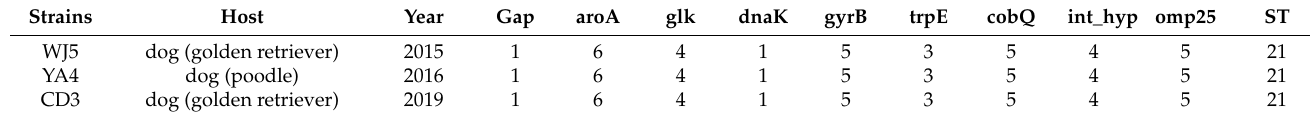
Table 4. Allelic profiles of three B. canis strains isolated from pet dogs in Sichuan, China.